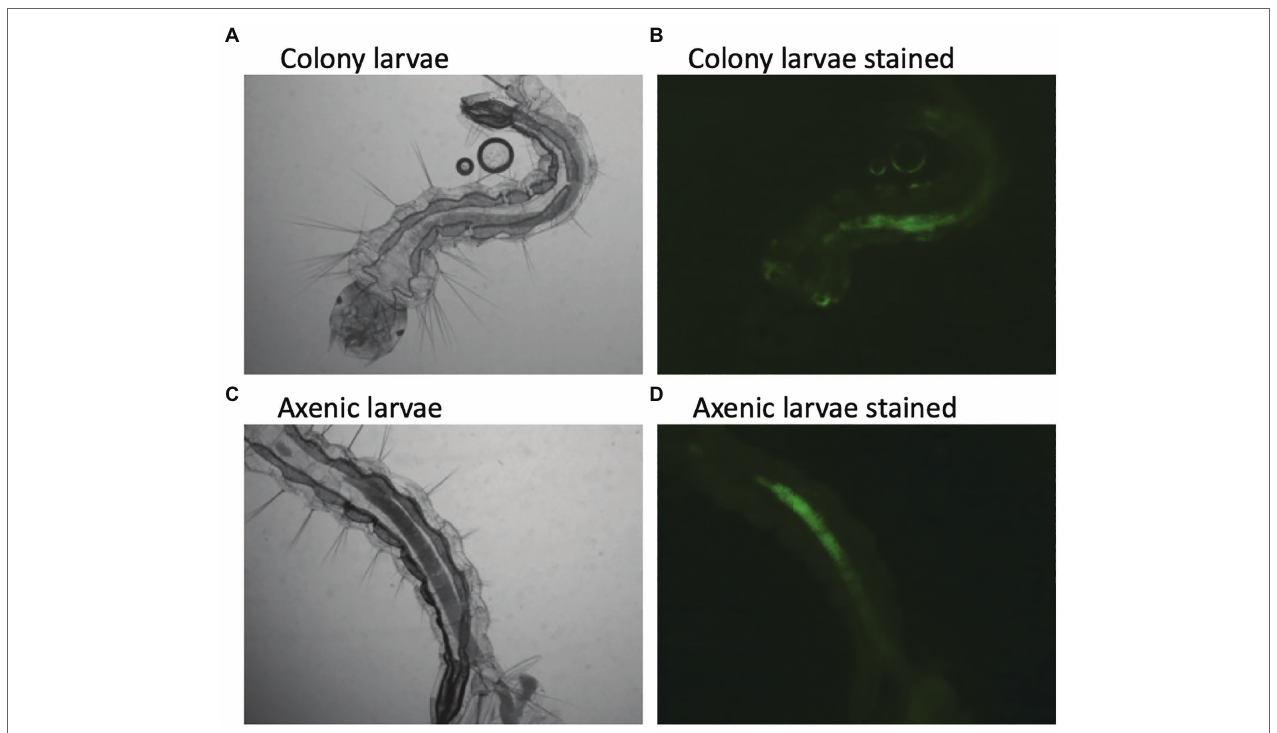
FIGURE 1 | Hypoxic conditions in the guts of conventionally reared and axenic Aedes aegypti larvae. Larvae were reared to the third instar of development and stained with Image-iT Hypoxia Reagent, which fluoresces in anoxic conditions (<5% oxygen). Axenic larvae were reared in the dark to protect light sensitive B-vitamins in the culture medium. A subset of axenic larvae were subsequently verified to be free of microbial contamination by both culture-dependent and culture- independent (16S rRNA and fungal rRNA gene PCR)